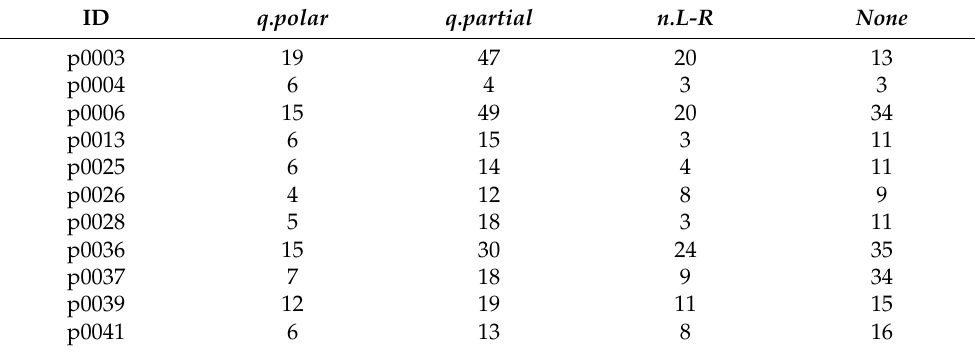
Table 4. Sample distribution (#samples) of LSE_GFE collaborators used in LOSO.